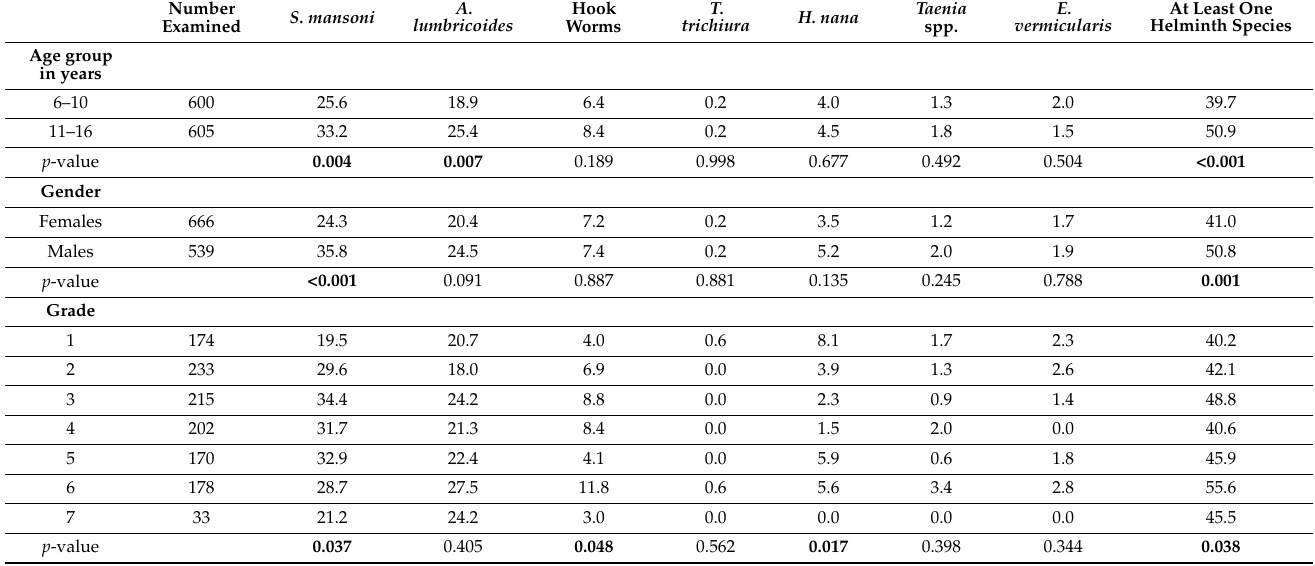
Table 1. Percent prevalence of intestinal helminth infection among school children in Maksegnit in May to July 2021 (N = 1205).